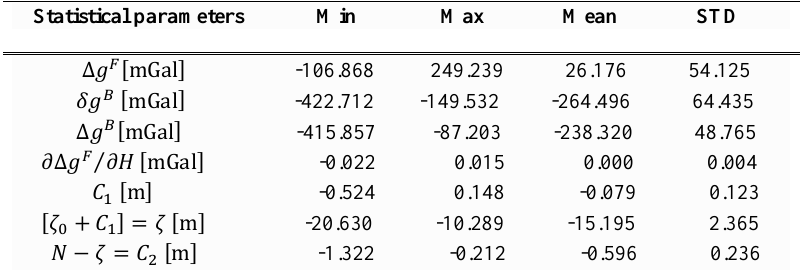
Table 3. The statistical parameters of GQS based on indirect